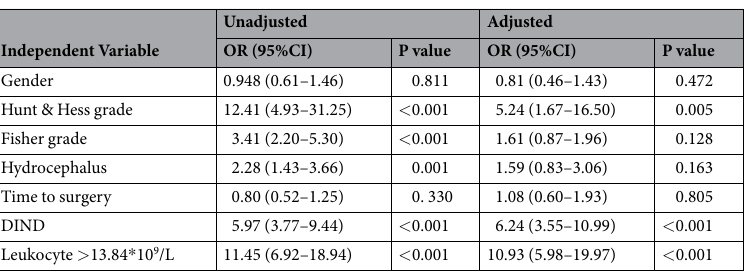
Table 2. Predictors of poor outcome for ruptured CA in multivariate model. OR = odds ratio; CI = confidence interval.